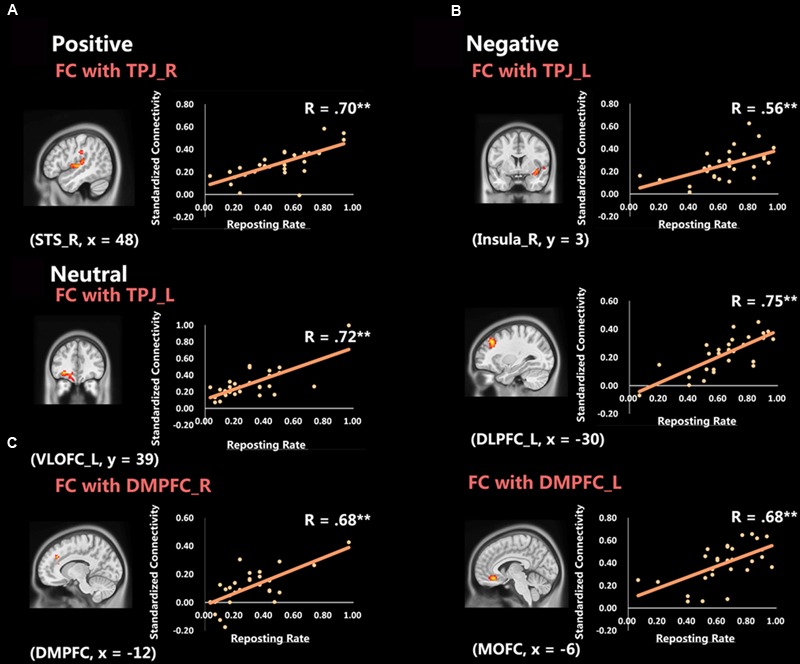
rs-fcMRI results for mentalzing seeds [Gaussian Random Field theory (GRF) corrected voxel threshold: | Z| > 2.32, cluster-level threshold: p < 0.05]. (A) Significant positive correlation between functional connectivity with right temporoparietal junction (TPJ) and reposting rate of positive microblogs in right STS. (B) Significant positive correlations between functional connectivity with left TPJ and reposting rate of negative microblogs in right insula and left DLPFC (middle frontal lobe), and significant positive correlation between functional connectivity with left dorsomedial prefrontal cortex (DMPFC) and reposting rate of negative microblogs in bilateral MOFC. (C) Significant positive correlation between functional connectivity with left TPJ and reposting rate of neutral microblogs in left VLOFC, and significant positive correlation between functional connectivity with right DMPFC and reposting rate of neutral microblogs in DMPFC.